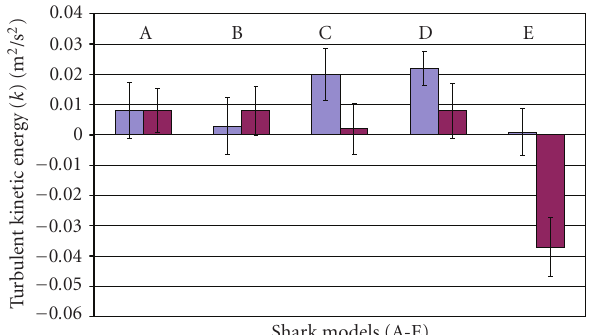
Figure 8: Di ff erence in mean ( ± St Err) turbulent kinetic energy ( k ) between models with and without the dorsal fin attached. The light series show the results for the shark body models and the dark series show the results for the control models. A positive di ff erence indicates a higher turbulent energy without the dorsal fin